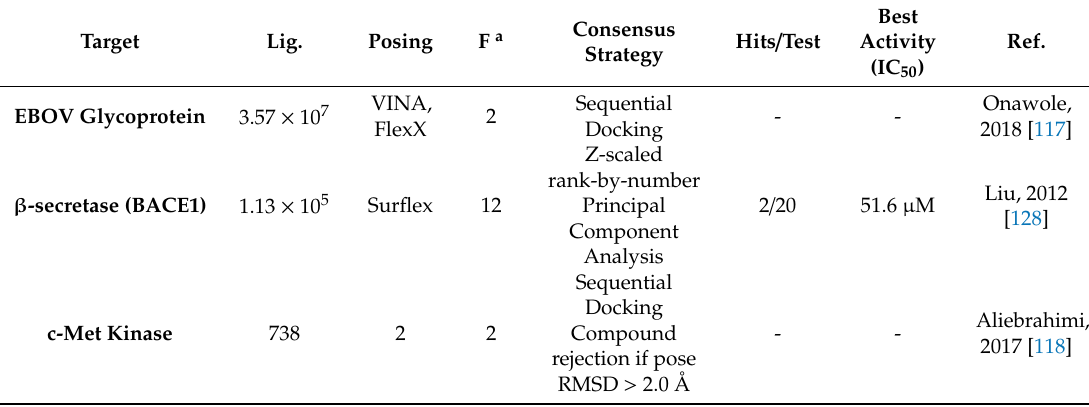
Table 3. Recent works using consensus docking